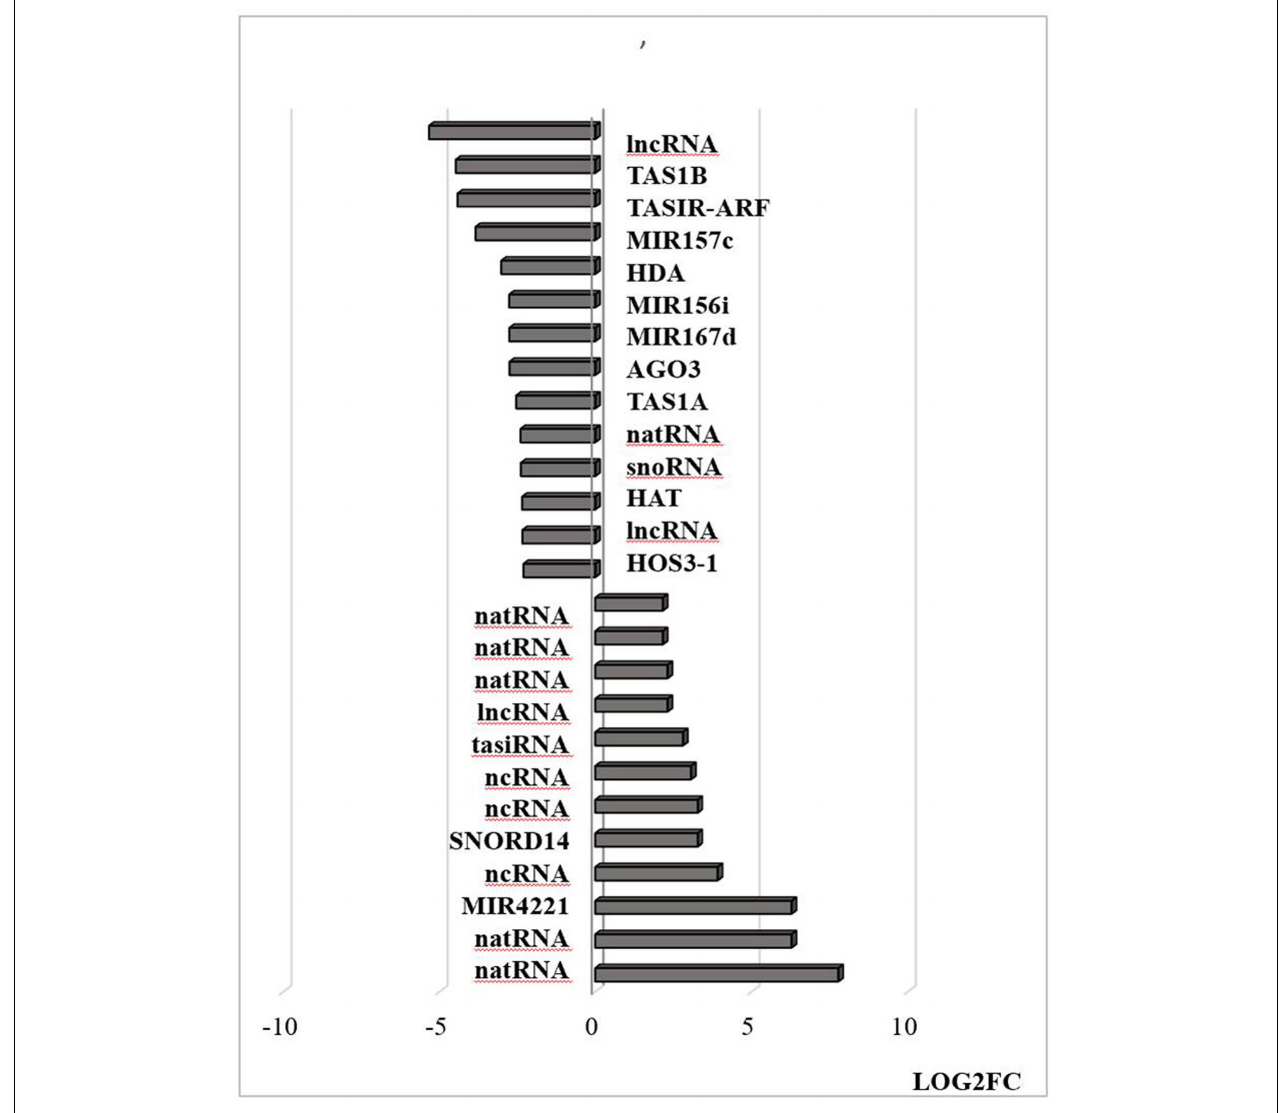
FIGURE 10 | Transcripts associated with small RNAs that are differentially regulated by heat stress. Examples of this class include Argonaute complexes (AGO) and histone deacetylase (HDAC). The abundance is expressed as (log2) fold change (LOG2FC). natural antisense RNAs (AT3G07365, AT3G04685, AT3G04685, AT1G04767, AT1G04767, AT5G03185); trans-acting siRNAs [AT1G63150, AT1G31130 (TAS1A), AT5G57735 (TASIR-ARF), AT1G50055 (TAS1B); AT1G75166 (snoRNA)], non-coding RNA (AT3G03215, AT3G41761, AT2G05205, AT4G06265, AT3G05655, AT5G03185, AT3G12502); microRNAs [AT4G06260 (MIR4221), AT1G31173 (MIR167D), AT1G07867 (MIR167D), AT1G31173 (MIR156i), AT3G18217 (MIR157C)] and proteins; AT1G31290 (AGO3), AT1G24145